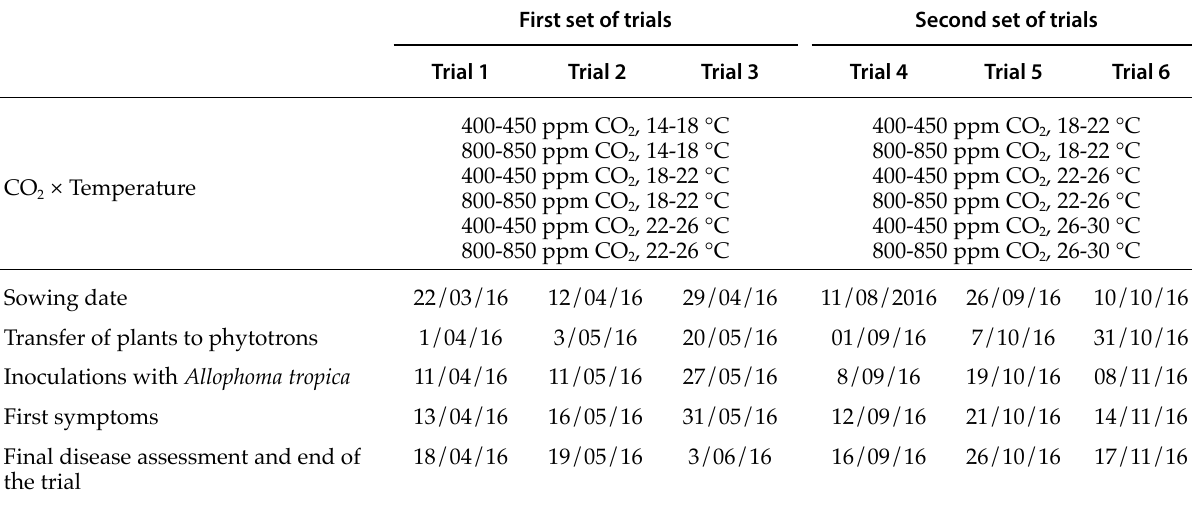
Table 1. Treatments and experimental details for six trials carried out on Allophoma tropica on lettuce (cv. Elisa). First set of